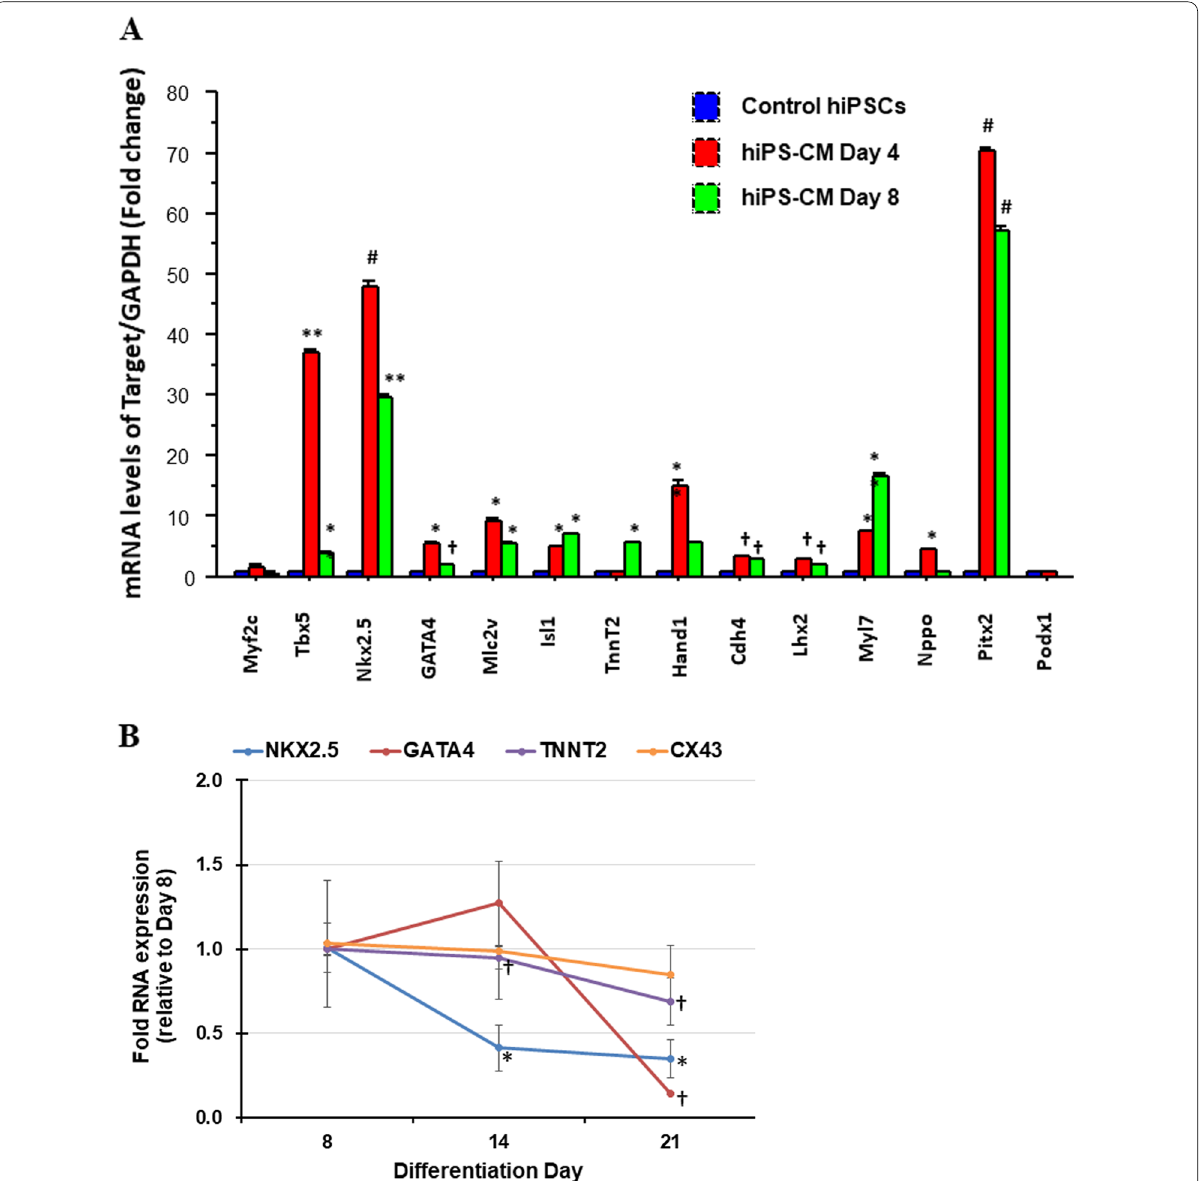
Fig. 7 Givinostat induce higher expression of cardiac myogenic genes: Cardiac genes included Pitx2, ISl1, Nkx2.5, Hand1, GATA4, Tbx5, TnnT2, Myl7, MLC2v, Mef2c, Cdh4 and Lhx2 versus control. GIV increased upregulation of cardiac muscle genes (Real Time PCR-analysis) for cardiac iPSCs (hiPSC-CM) after 4 days. Cardiac maturity genes were followed up at day 14 and Day 21 with normalized to day 8 ( B ). Values are mean P- value < 0.05, * P-